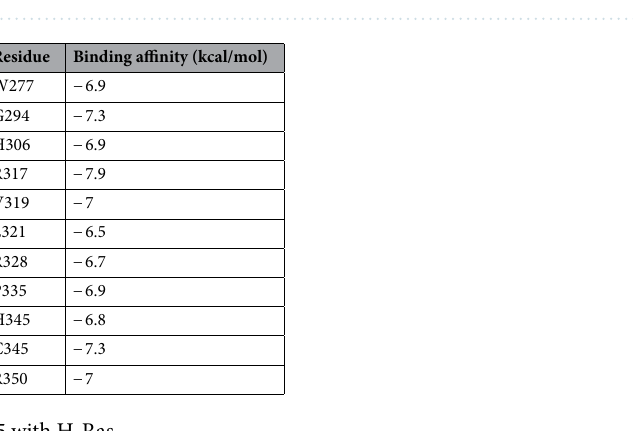
Figure 6. Molecular docking analysis of wild type and mutant peptide of P350R with H-Ras protein. ( a ) Native peptide sequence (P350). ( b ) Superimposed image of native peptide sequence and H-Ras protein. E353 forms two H-bonds with Gly60, one H-bond with G13 and another with G15. L347 forms one H-bond with E31. ( c ) Mutant peptide sequence (R350). ( d ) Superimposed image of mutant peptide sequence with H-Ras protein. Three new H-bonds are formed with the H-Ras protein where G353 forms two H-bonds with T35, and D33. Moreover, D351 forms single H-bond with K147.